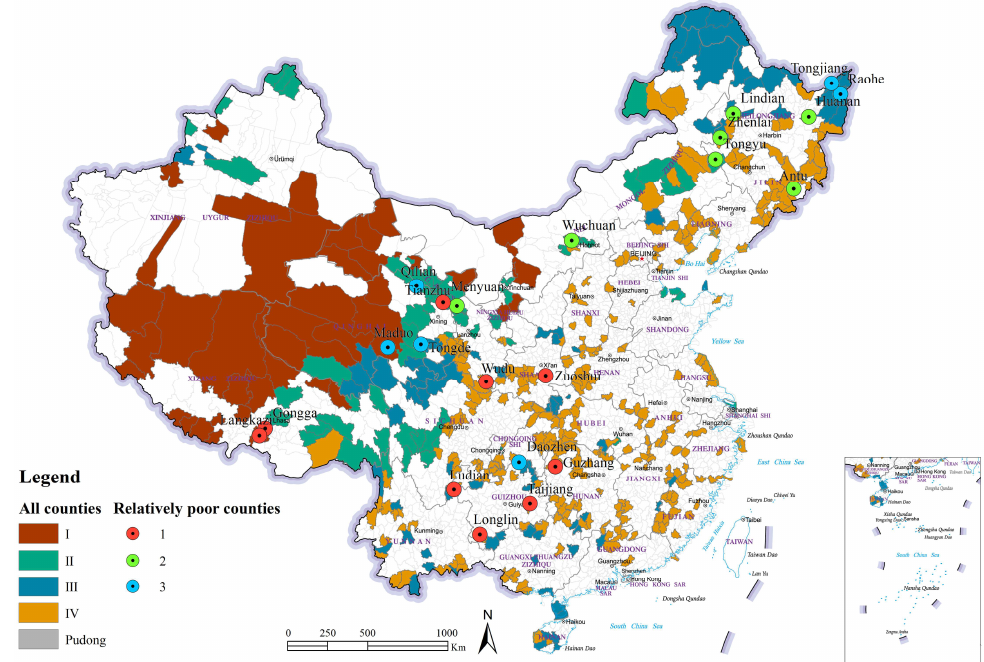
Figure 7. Dimensionality clustering.